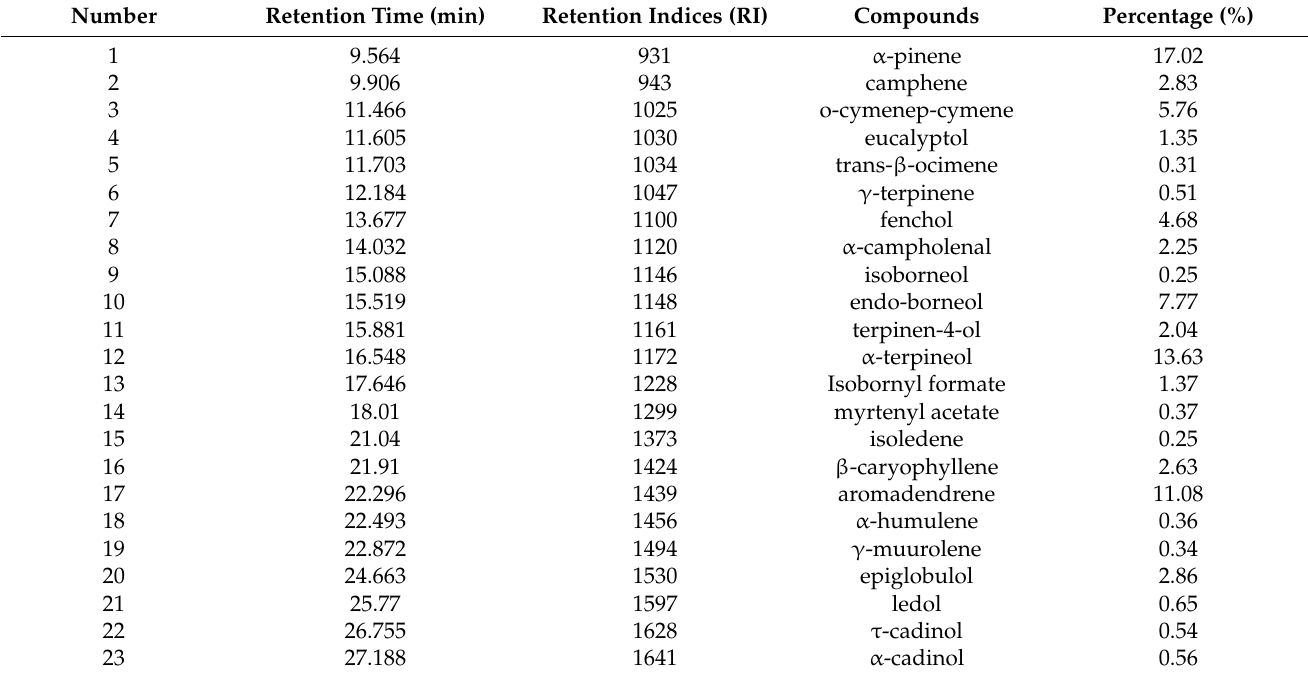
Table 1. Chemical compositions of